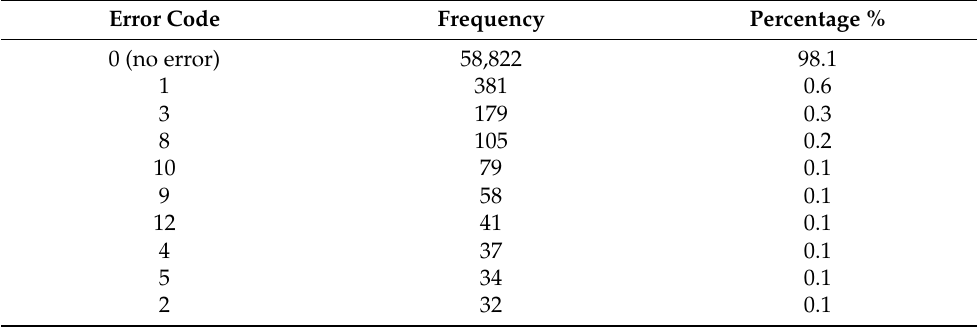
Table 4. Frequency of the main errors of the park during a year.